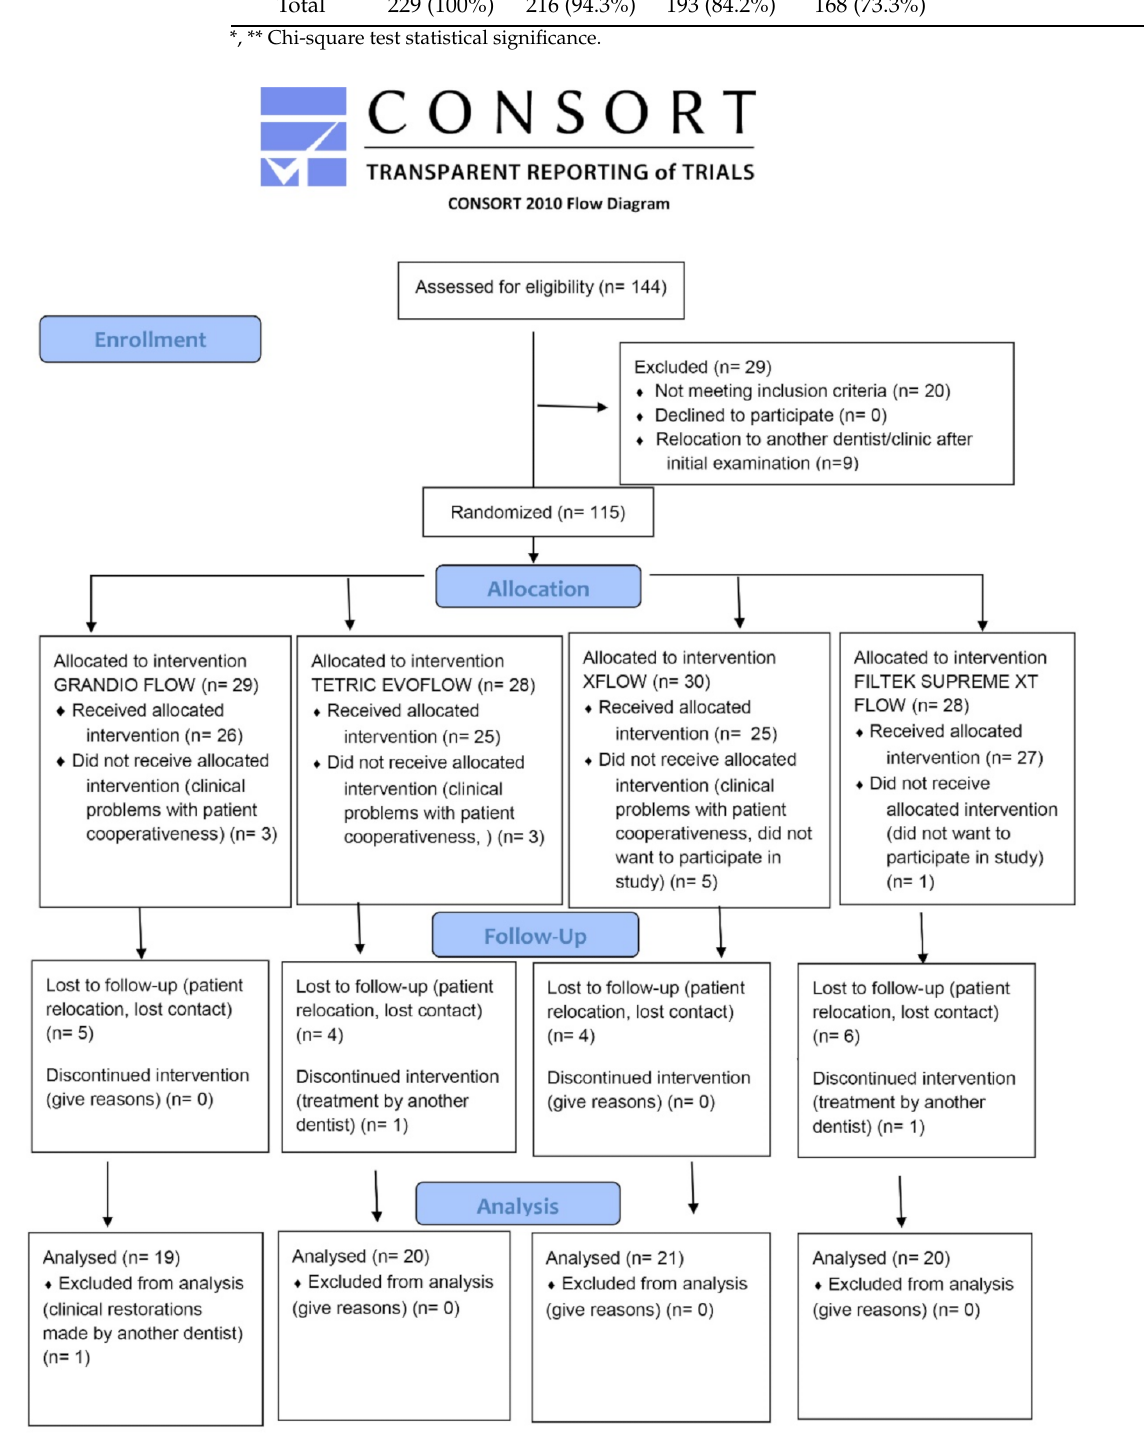
Figure 1. The CONSORT flow